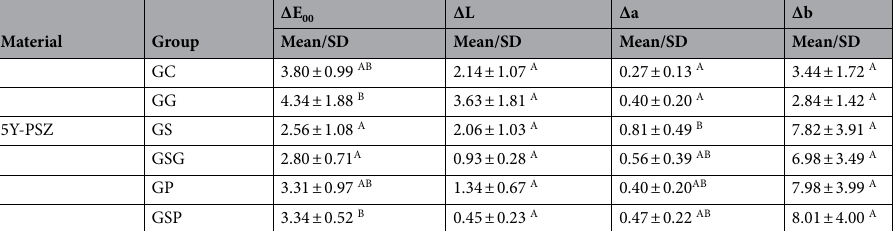
Table 2. Means and standard deviation and the statistical differences after Tukey’s test of color change ∆E 00 , ∆L, ∆a and ∆b for groups at times 1 and 2. *Different letters indicate statistically significant differences between lines. * SD Standard deviation.